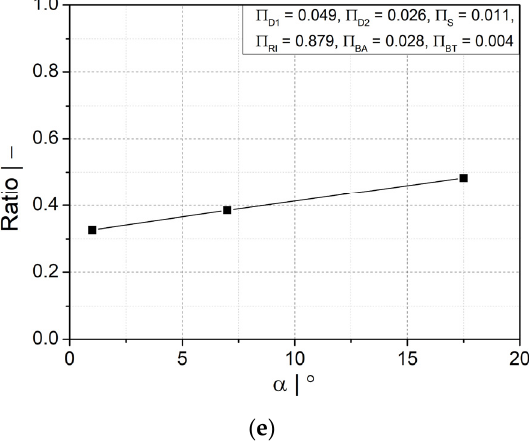
Figure 8. Ratio of wall thicknesses at crest and valley as a function of dimensionless ( a ) initial thickness of fluid parison ∏ S ; ( b ) half profile width at crest ∏ B ; ( c ) crest diameter ∏ D ; ( d ) mold block inner radius ∏ R ; and ( e ) flank angle α . Table 3. Multiple regression analysis output from the screening design study. Term